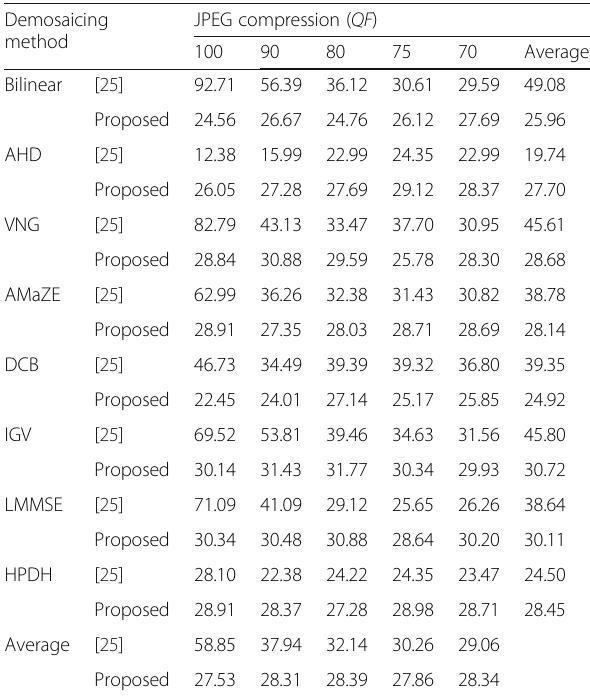
Table 8 Estimation accuracy comparison between conventional algorithm and proposed method with JPEG compression for different demosaicing methods (unit %). Block size fixed to 256 ×